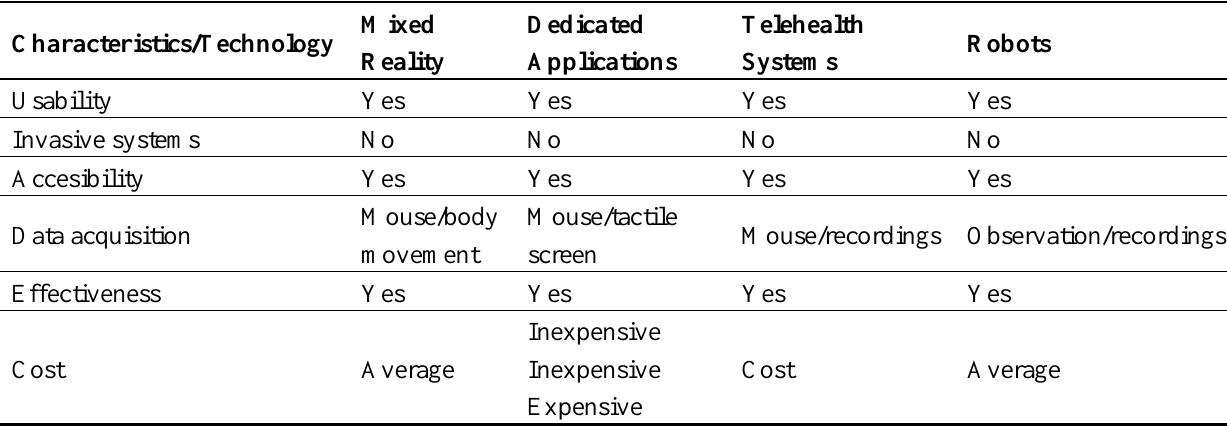
Table 5. Comparison of the characteristics of the